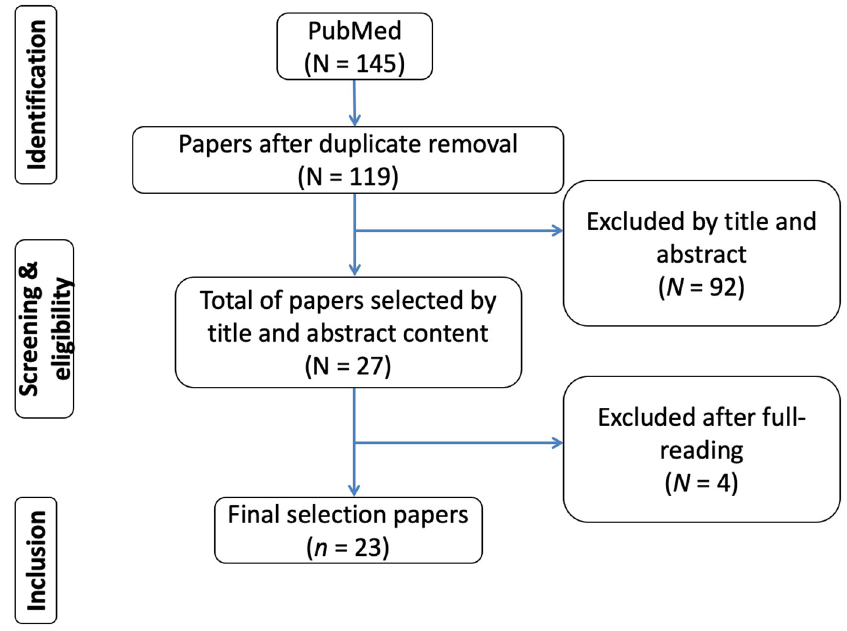
Figure 1. Flow diagram of the search strategy used in this study.